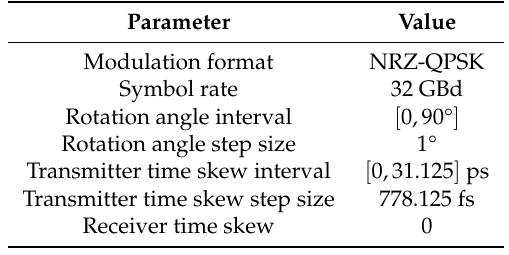
Table 1. Parameters for B2B evaluation of CTA due to transmitter time skew.